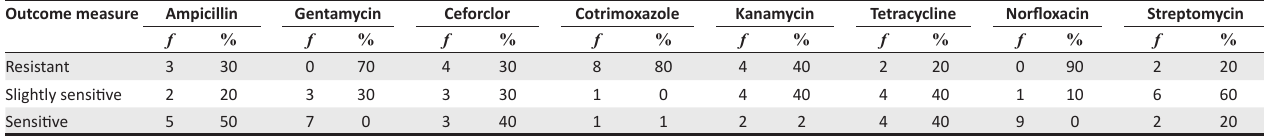
TABLE 6: Sensitivity results against antimicrobials for Streptococcus agalactiae isolated from subclinical mastitis at the cow-level during the first farm visit ( n = 10) from Mukurwe-ini and Nakuru Districts, Kenya, June 2010 to August 2010. Outcome